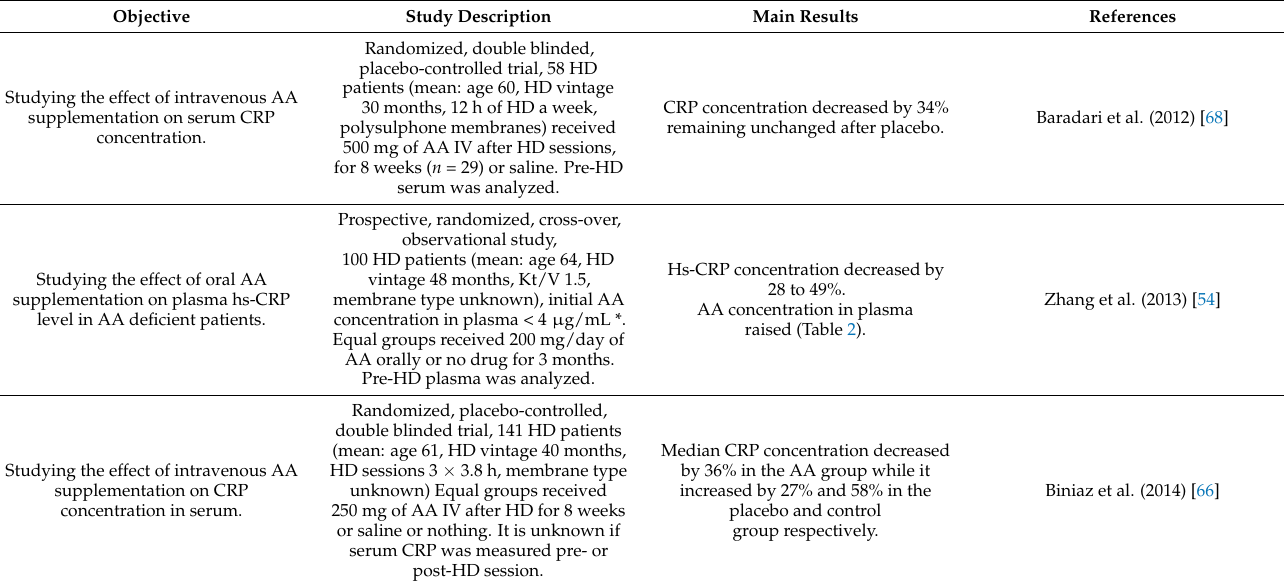
Table 4. The inhibitory effect of ascorbic acid supplementation on the intensity of inflammation in hemodialysis patients. Objective Study